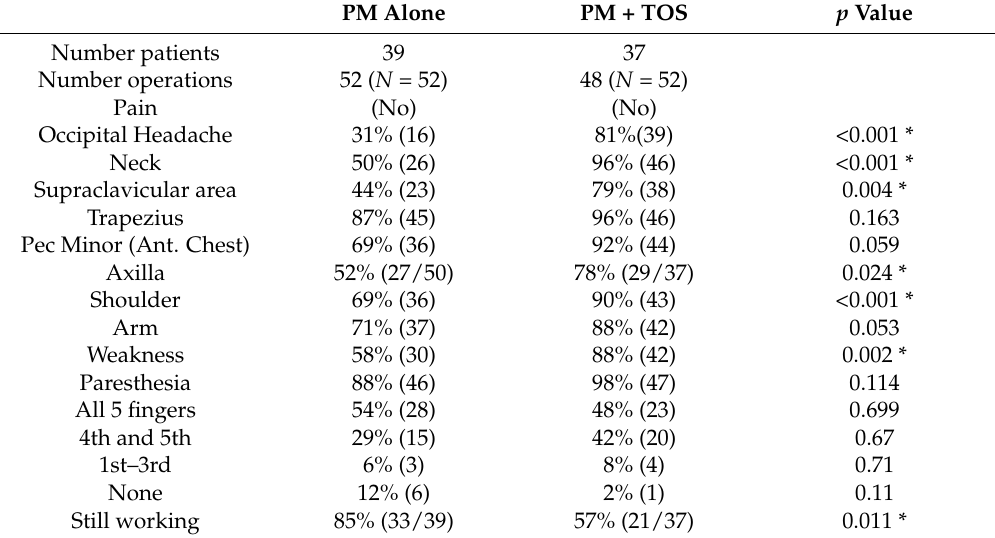
Table 1. Symptoms of pectoralis minor (PM) alone and with neurogenic thoracic outlet syndrome (NTOS). PM Alone PM + TOS p